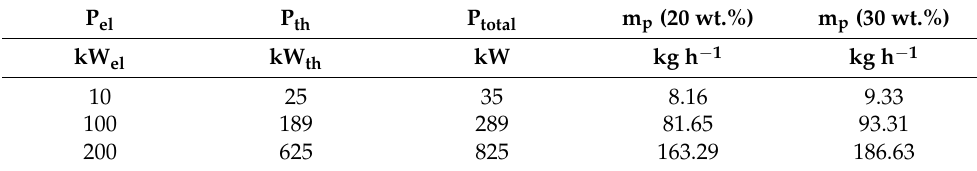
Table 4. Wood chip consumption rates for chosen variants of electric power and input material moisture.